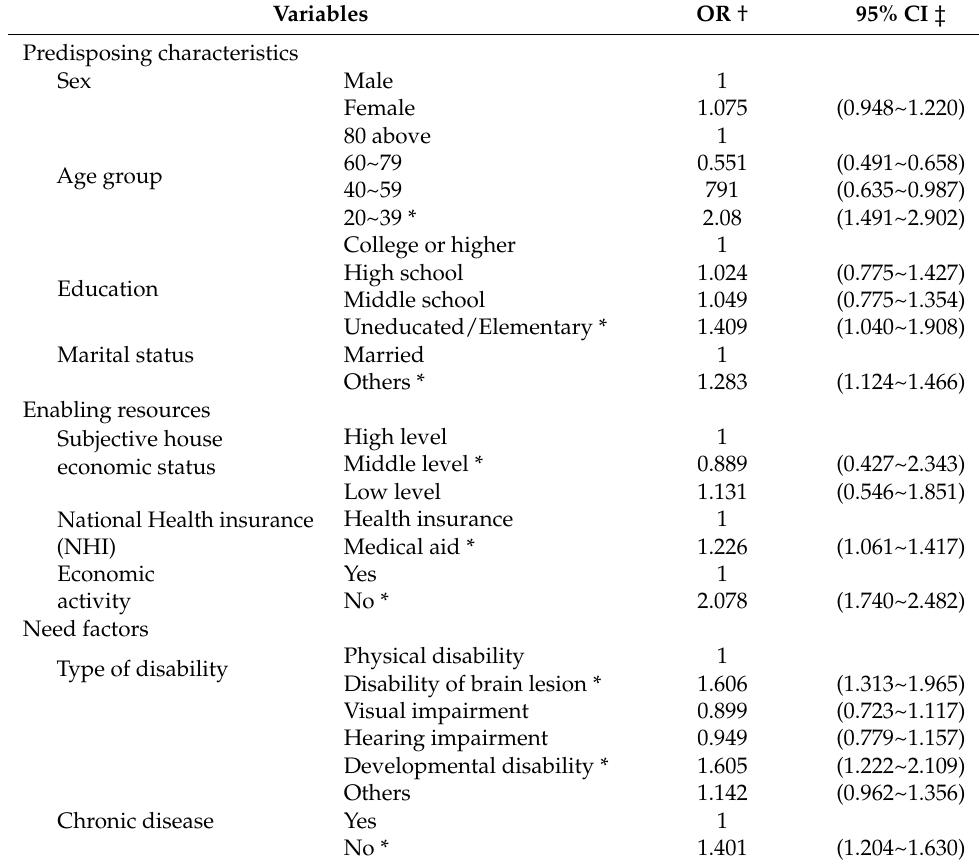
Table 4. Factors affecting health screening non-participation among people with disabilities (N = 6660). Variables OR † 95% CI